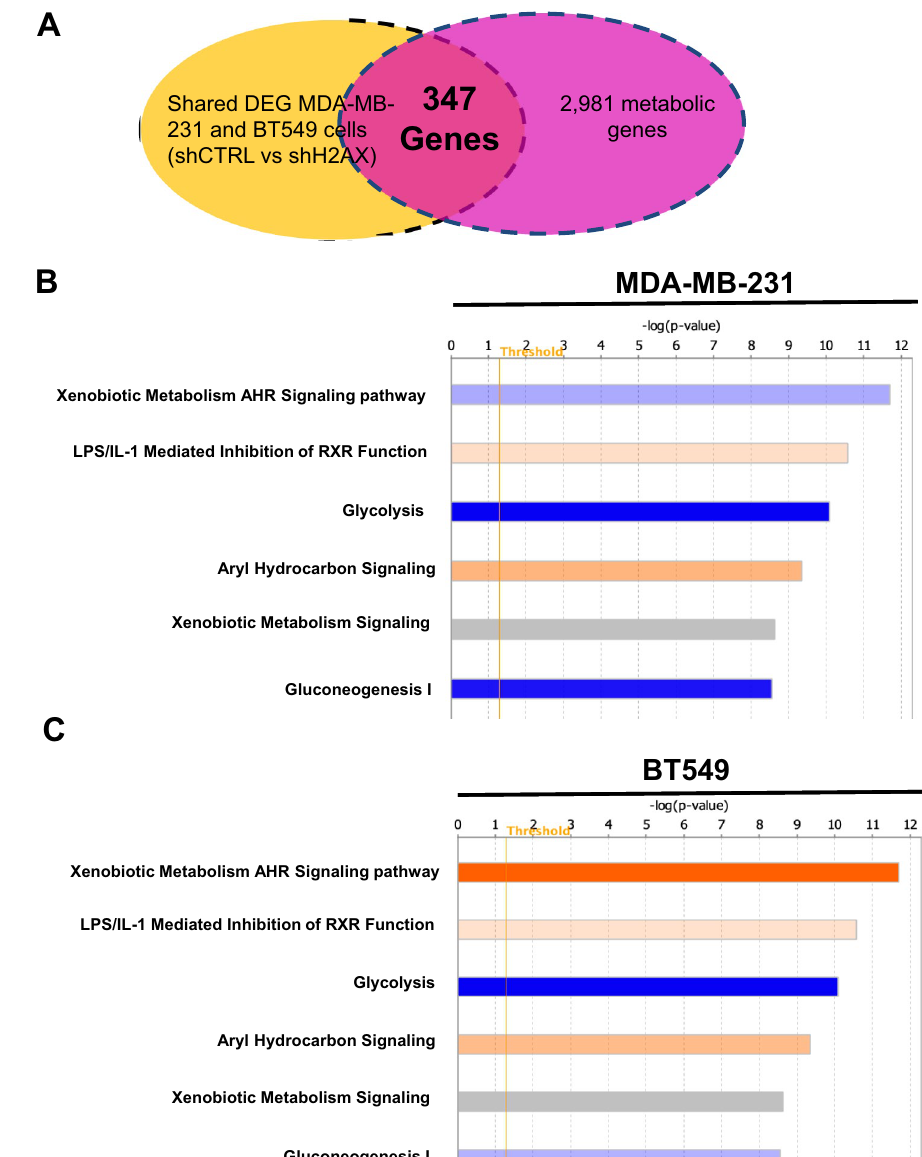
Figure 1. H2AX is a key player in the regulation of glycolysis in triple-negative breast cancer cells. ( A ) MDA-MB-231 and BT549 cells were transfected with scrambled short hairpin RNA (shCTRL) or with short hairpin RNA against H2AFX (shH2AX), and the resulting cells were used for transcriptomics to generate Differentially Expressed Genes (DEG) between shCTRL and shH2AX. DEG were merged with 2981 metabolic genes to identify genes regulated by H2AX. The output from the overlay between the two genes sets revealed 347 genes commonly shared and consistent in both MDA-MB-231 and BT549 cells. ( B , C ) Ingenuity Pathway Analysis ( IPA ) was used to establish cellular pathways in which the 347 metabolic genes are involved. The output revealed enrichment for multiple pathways involved in metabolic reprogramming of cancer cells. Glycolysis pathway is significantly repressed in both cell lines. Blue bars represent repressed pathways, and orange bars represent activated pathways. Grey bars indicate a pathway with fewer molecules and limited enrichment for a prediction. The height of the bar represents the p-value. The yellow line indicates the log (p-value) threshold of significance (1.3), which corresponds to p-value of 0.05. Statistical significance was determined by Fishers